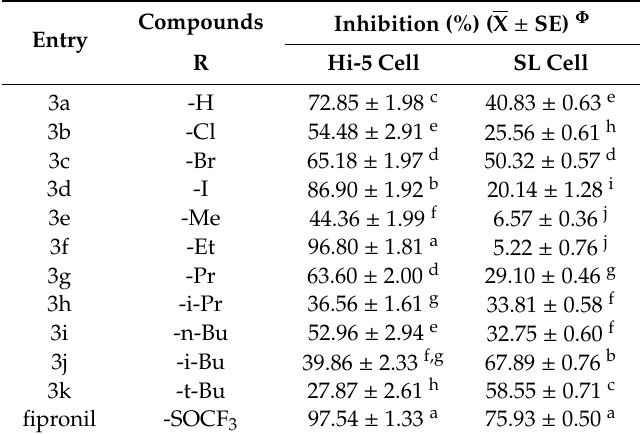
Table 1. The cytotoxicity of compounds 3a – 3k and fipronil on the Trichoplusia ni (Hi-5) cell and Spodoptera litura cell (SL) cell determined by the MTT